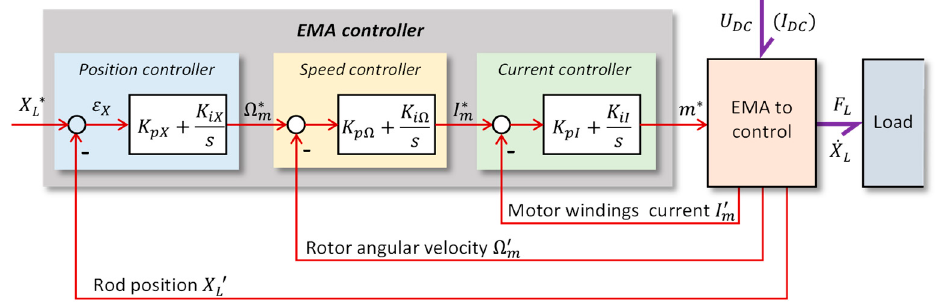
Figure 1. Cascade control of EMAs (notations are detailed in the Appendices A and B, full arrows and half arrows highlight the signal and power flows, respectively).